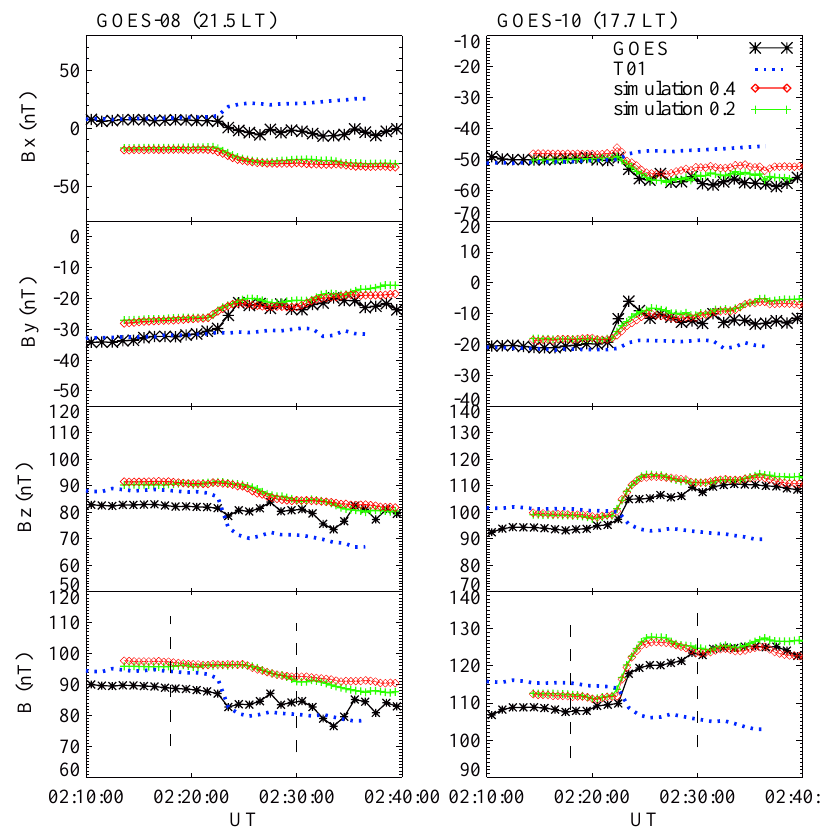
Fig. 6. Magnetic field at GOES-08 (left) and -10 (right) for the 4 November 2000 event. Figure formats are similar to Fig. 2. Green crosses (red diamonds) show the results with 0.2 (0.4) R E spacial